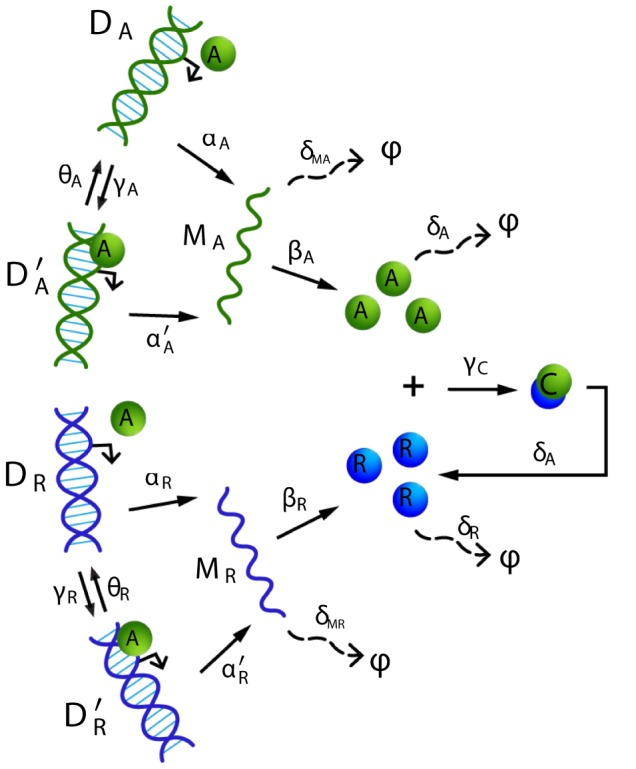
Circadian clock model of [65].